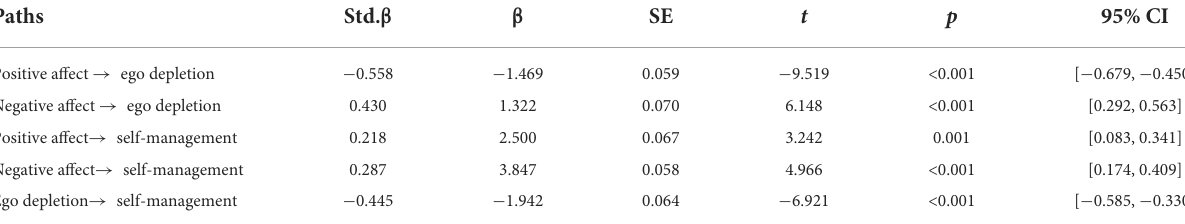
TABLE 3 Path coefficients of the mediation model ( n = 383). Paths